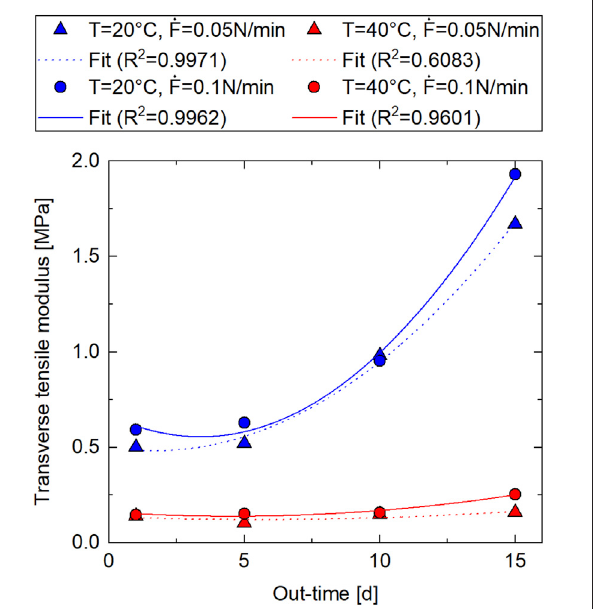
FIGURE 9 | Transverse tensile modulus results as a function of out-time from DMA transverse tensile tests (Material: IM7/8552 prepreg; out-time: 1 day – 15 days at T (cid:1) 21 ° C , RH (cid:1) 40 %